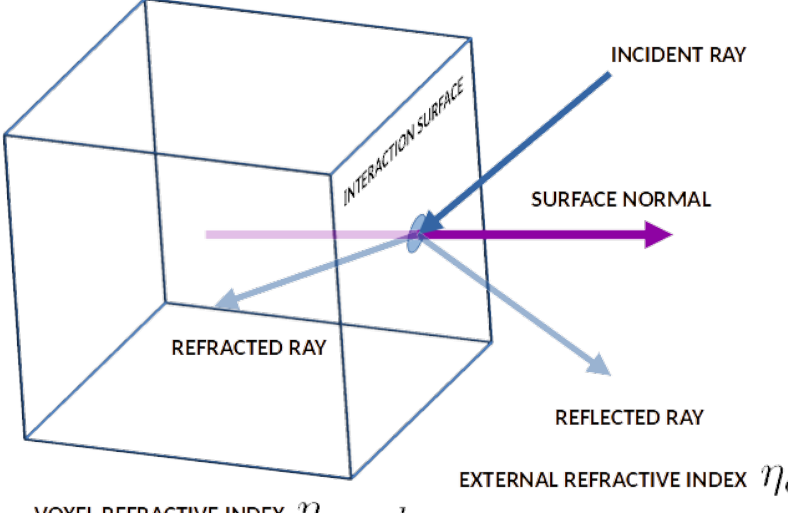
Figure 2. Interactions of the incident ray on a voxel surface.